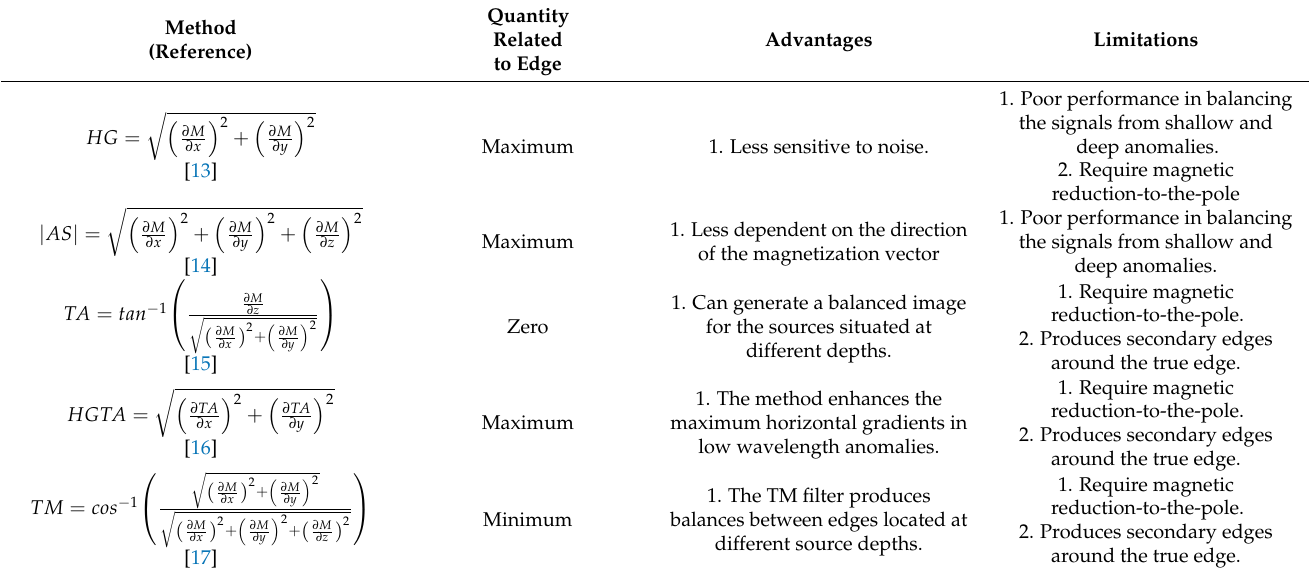
Table 1. Previous edge detection techniques. Abbreviations are used in the table for reducing the column size and are listed as follows: HG: Horizontal Gradient; AS: Analytic Signal; TA: Tilt angle; HGTA: Horizontal gradient of tilt angle; TM: Theta map; TDX: Normalized horizontal tilt; HTA: Hyperbolic tilt angle; TAHG: Tilt angle of the horizontal gradient; TBHG: Tilt angle of the balanced horizontal gradient; TAAS: Tilt angle of the analytic